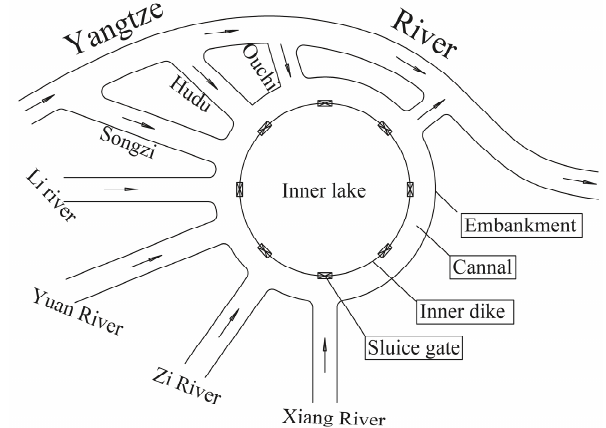
Figure 4. The schematic of the innovative flood control scheme (IFCS).